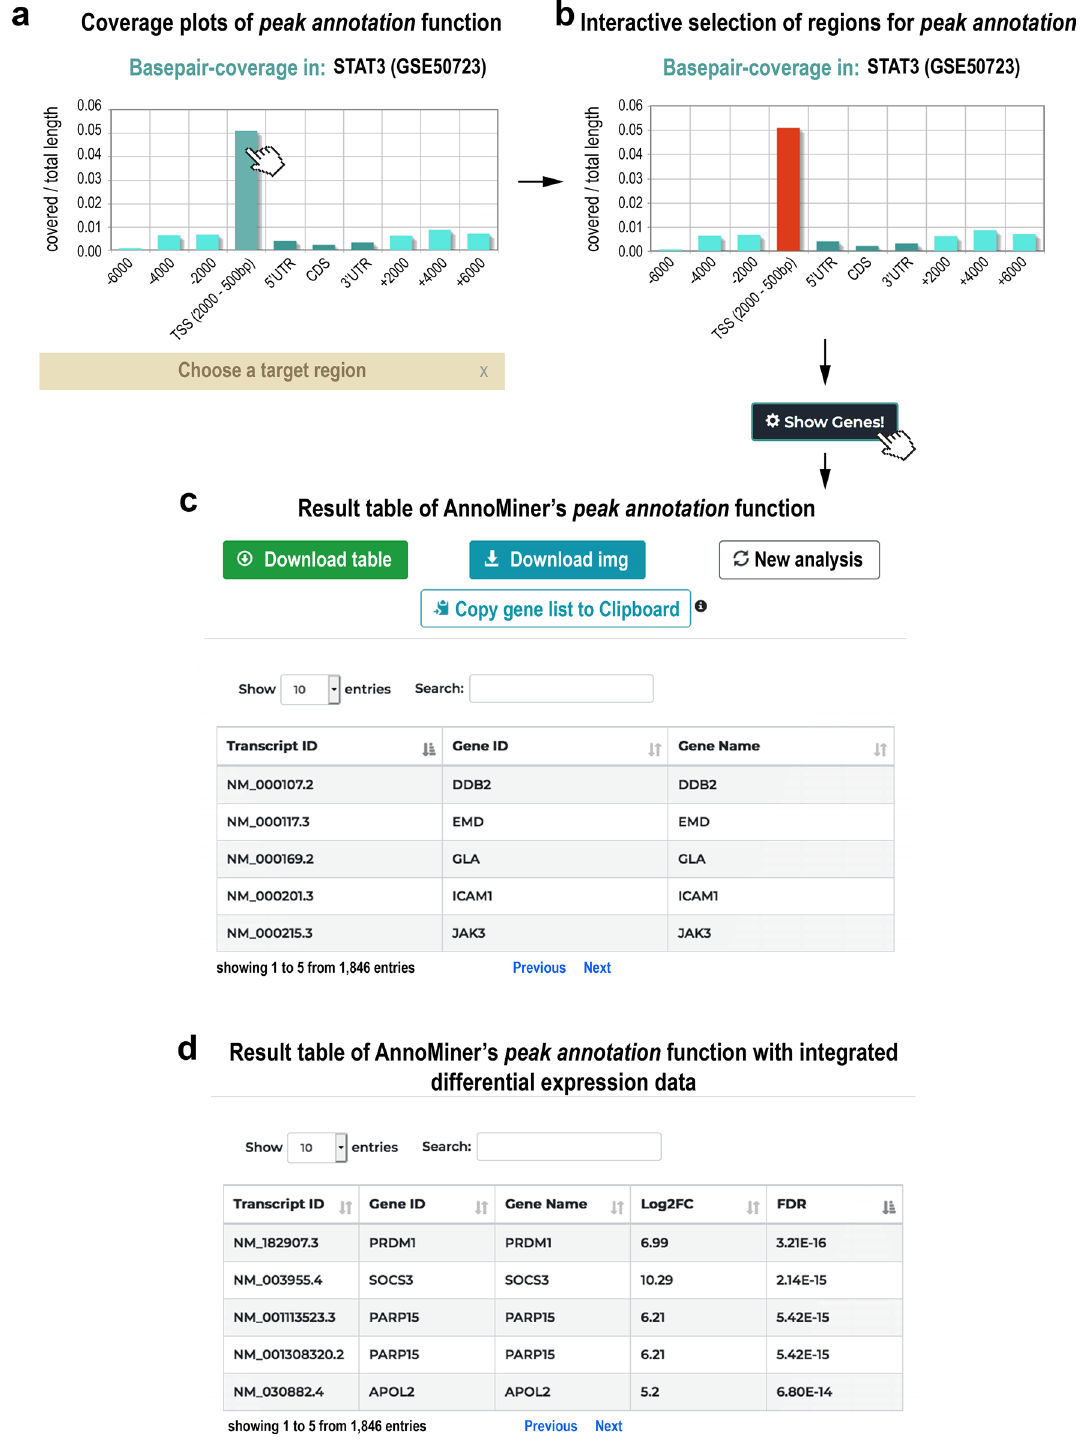
Figure 3. Peak annotation function of AnnoMiner. In the peak annotation function, AnnoMiner allows users to annotate peaks from a BED file. ( a ) After uploading a BED file to the server and choosing the function peak annotation , a coverage plot is produced, showing the covered base-pairs/total length relative to attributes extracted from the gene features of an organism’s genome. These include the 5 ′ upstream flanking region, the TSS (− 2000 bp and + 500 bp), the 5 ′ UTR, coding sequence (CDS), 3 ′ UTR, as well as the 3 ′ flanking region, whereby the boundaries for the TSS and flanking regions can be set by the user. ( b ) The plot is interactive and the user should select the target region (corresponding to the attribute of interest) to be analysed by selecting one or more bars to proceed. ( c ) When clicking on ‘Show Genes!’, the user retrieves a list of associated genes that fulfils the selected overlap criteria with the peaks. The table can be sorted according to different values, downloaded, browsed online, or the gene list can be copied to the clipboard for further analysis (e.g. enrichment analysis). The user can also select a new target region or start a completely new analysis. Significant differential peaks from STAT3 (GEO dataset GSE50723) were uploaded for producing this Figure. For ( d ), differential expression data were uploaded from the associated GEO dataset GSE50721 from super-series